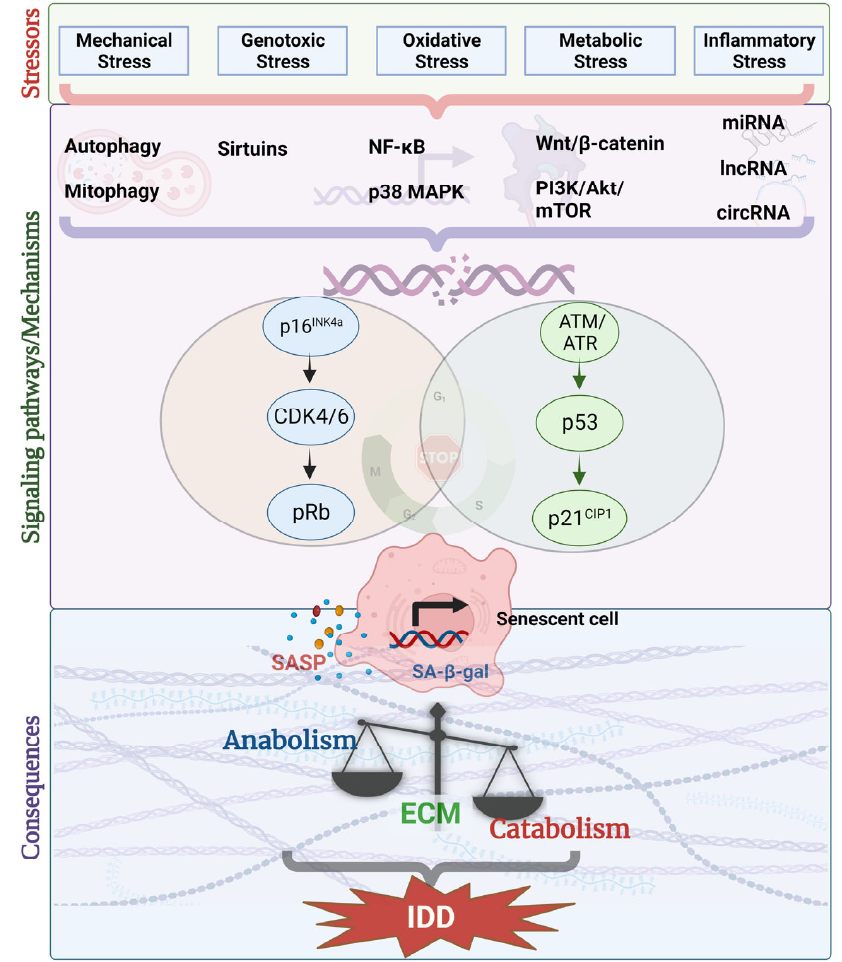
Figure 1. Overview of cellular senescence during intervertebral disc degeneration. The reported pathways of stressors, signaling molecules, and consequences of cellular senescence (CS) during intervertebral disc degeneration (IDD) are depicted. During aging, disc CS can be caused by mechanical, genotoxic, oxidative, metabolic, and inflammatory stress which activate signaling cascades such as NF-kB, mitogen activated protein kinases (MAPKs), Sirtuins, PI3K/Akt/mTOR, etc., and cellular mechanisms such as autophagy and mitophagy or they directly activate the DNA damage response to induce the senescence pathway. The senescence signals and DNA damage responses activate the ATM-p53-p21 CIP1 and p16 INK4a -pRb pathways, which work reciprocally with each other to induce cell cycle arrest and senescence. Disc CS associated secretory phenotype (SASP) produces and secretes pro-inflammatory and catabolic factors such as MMPs to further amplify the process of disc degeneration. As a consequence of changed cellular phenotype, extracellular matrix (ECM) catabolism is increased, and anabolism is reduced leading to degradation of the disc tissue. (Figure created with BioRender.com, accessed on 8 March